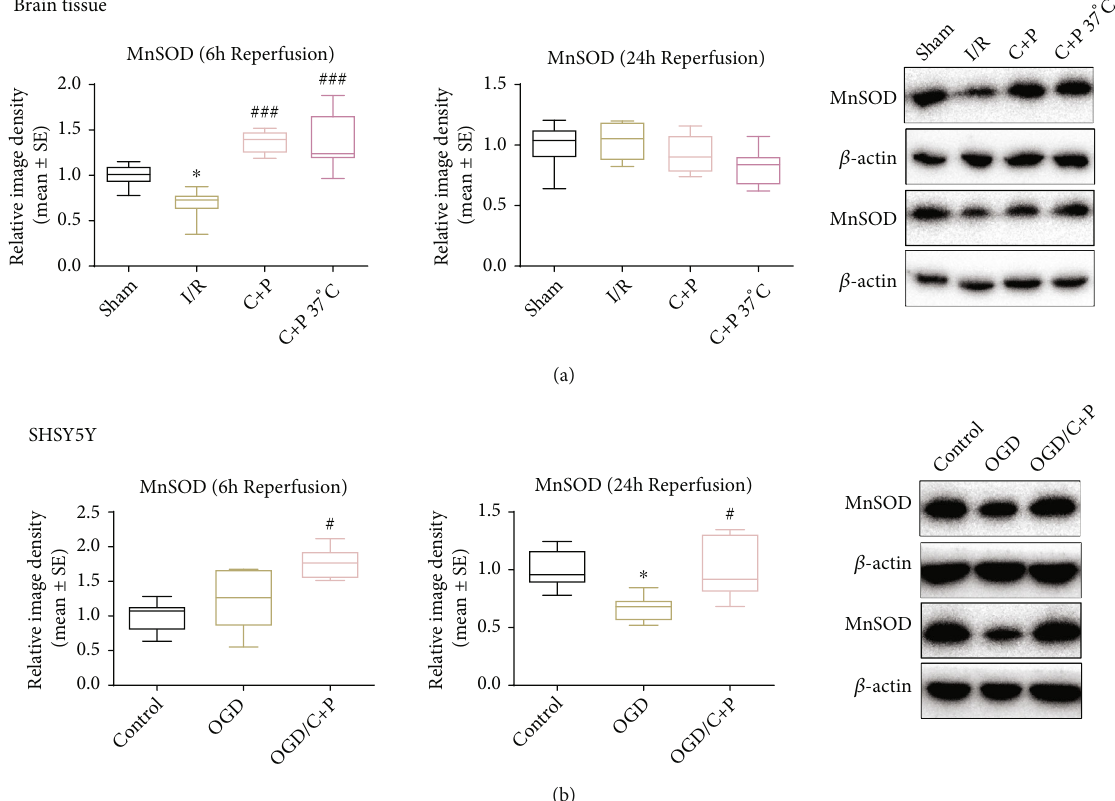
Figure 7: C+P facilitated the expression of MnSOD after cerebral ischemia or OGD/R. (a) Representative bands of MnSOD in brain tissue as identi fi ed using Western blot at 6 and 24 hours of reperfusion. β -Actin served as an internal control. Semiquantitative levels of MnSOD are displayed in bar graphs, identi fi ed using band density analysis. MnSOD protein levels decreased after I/R. C+P administration signi fi cantly accelerated MnSOD expression at 6 hours of reperfusion ( n = 7 ). ∗ p < 0 : 05 versus the sham group; ### p < 0 : 001 versus the I/R group. The data is presented as mean ± SE . (b) Representative bands of MnSOD expression in SHSY5Y cells as identi fi ed using Western blot at 6 and 24 hours of reoxygenation. β -Actin protein served as an internal control. Bar graphs show semiquantitative levels of MnSOD as identi fi ed using band density analysis. MnSOD protein levels decreased at 24 hours of reoxygenation. However, C+P therapy elevated MnSOD expression at 6 and 24 hours of reoxygenation. ∗ p < 0 : 05 versus the OGD group; # p < 0 : 05 versus the OGD/C+P group. Results are shown as mean ± SE of three independent